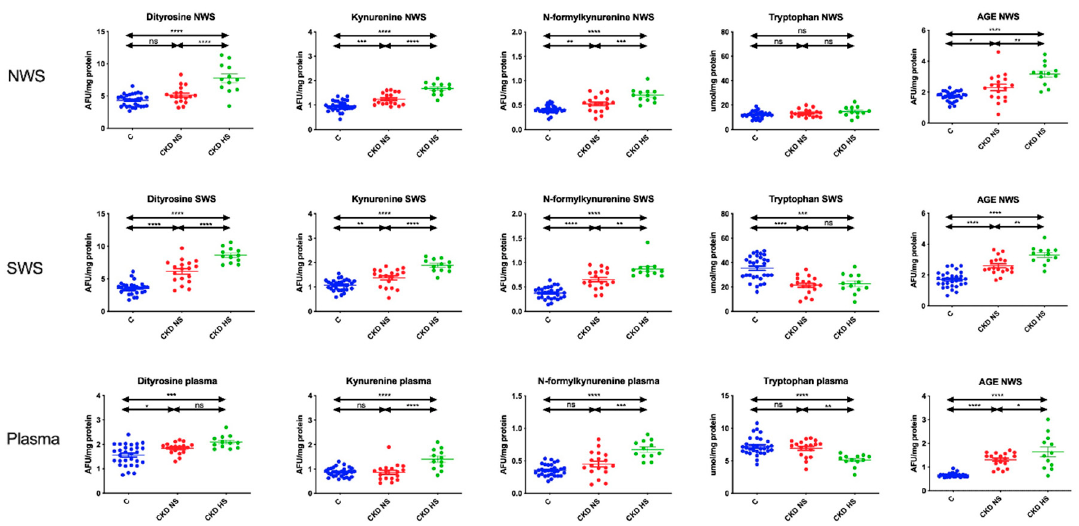
Figure 2. Glycooxidation products in children with chronic kidney disease (CKD) and healthy controls. AGE—Advanced glycation end products; C—Healthy controls; CKD NS—CKD patients with normal salivary secretion; CKD HS—CKD patients with reduced salivary secretion; NWS—Non-stimulated whole saliva; SWS—Stimulated whole saliva. Differences statistically significant at: * p < 0.05, ** p < 0.005, *** p < 0.0005, **** p < 0.0001.